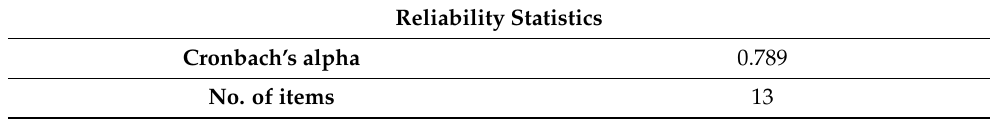
Table 2. Cronbach’s alpha reliability